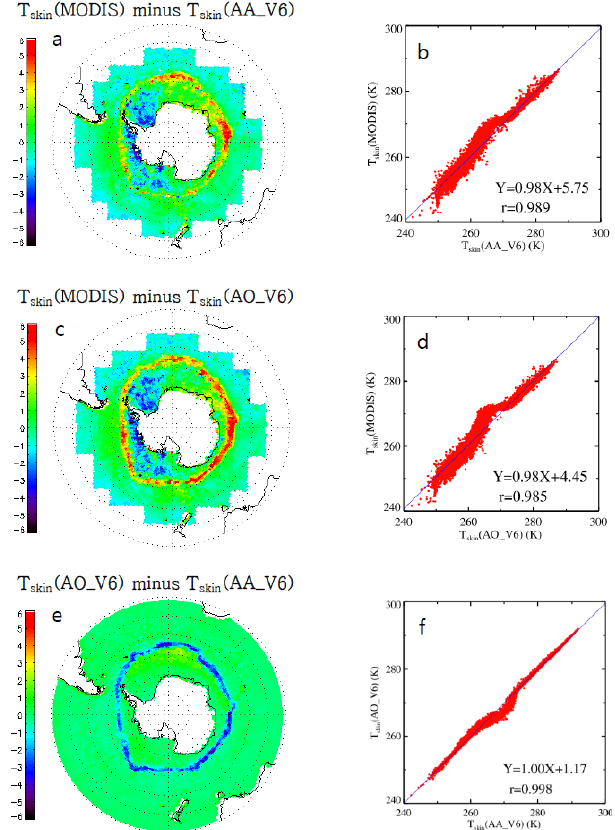
Figure 4. Same as in Fig. 3 except for the data taken during 15– 23 September 2003–2014, over the Southern